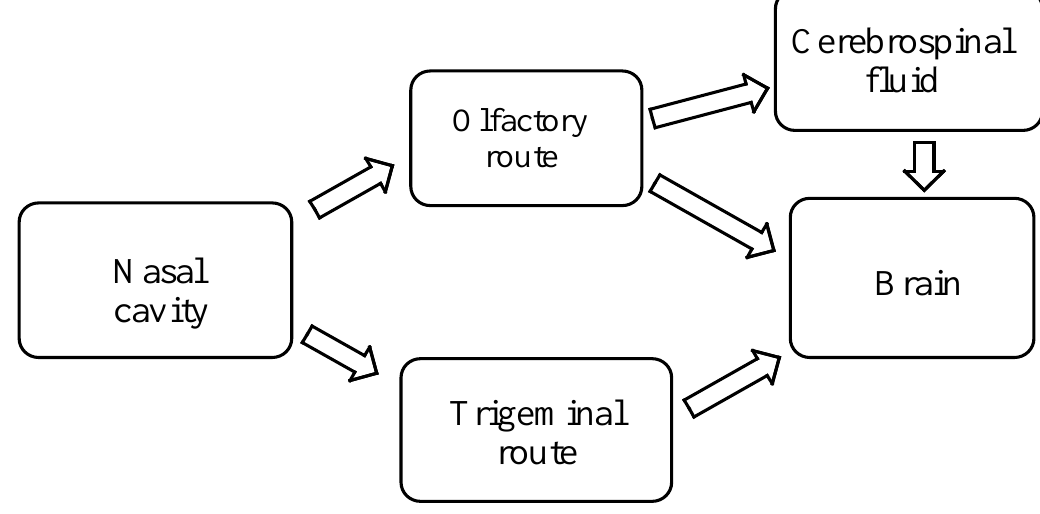
Figure 2. Pathways of nose-to-brain delivery.